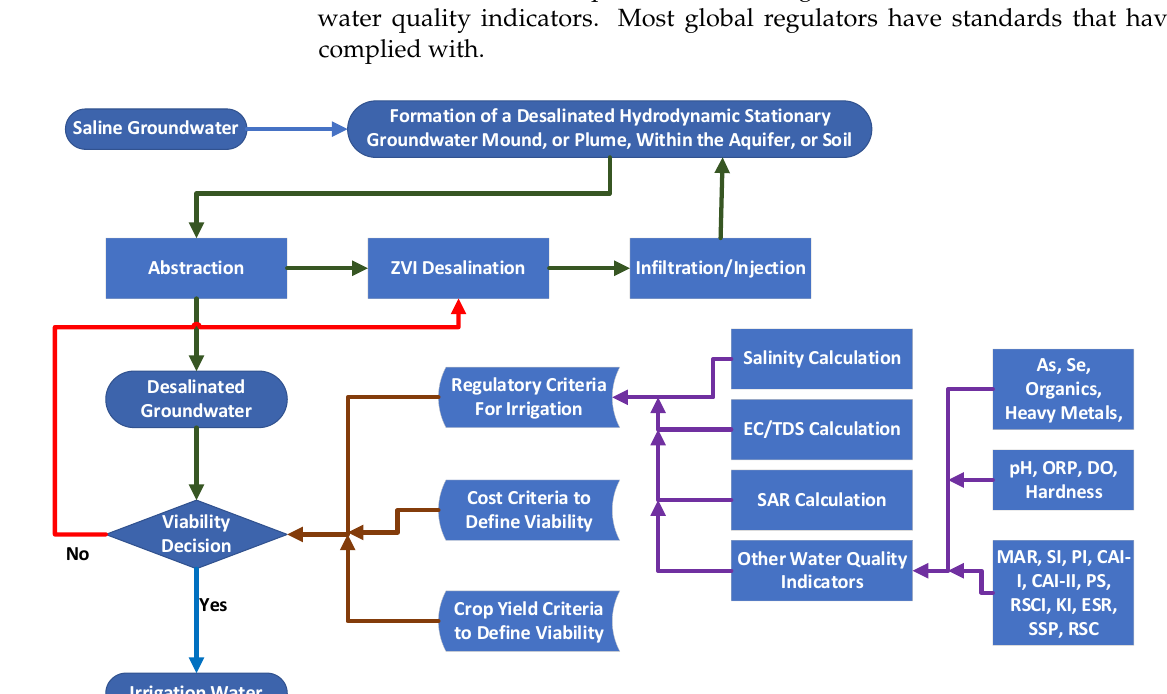
Figure 2. The desalination concept evaluated by this study. An aquifer or soil is used to provide temporary (or permanent) storage for the desalinated water. Blue arrow = saline water source; Green arrow = desalination processing; Brown arrow = decision criterion; Purple arrow = regulatory water quality indicators; Red arrow = water returned for further processing. Patterns associated with ZVI desalination are provided in Appendix B; Regulatory water quality indicators are summarized in